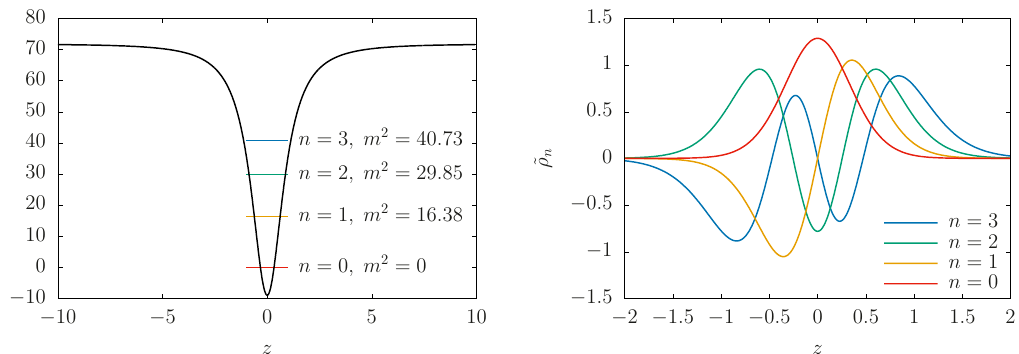
Figure 2 . In the left (cid:12)gure, the black line represents the potential V III ( z ), and colored lines represent the position of mass spectra in the potential. The right (cid:12)gure shows the corresponding solutions of ~ (cid:26) n (nomalized). Parameters C 3 = 0 : 5 ; C 2 = 20, and k = 1.